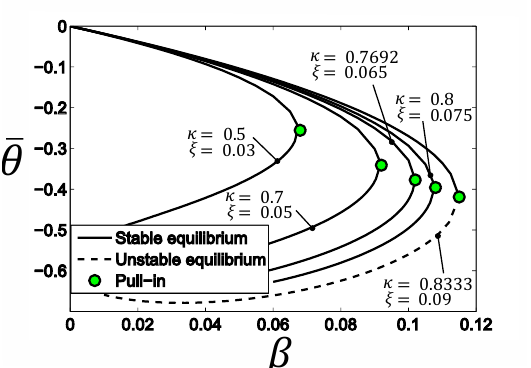
Figure 4. Stable and unstable angular equilibrium of the tilt-disc and its evolution depending on the parameters of device such as ξ = h l /2 R l and κ = h / h l , where h is the space between an electrode plane and equilibrium point of the disc, R l is the radius of levitation coil.